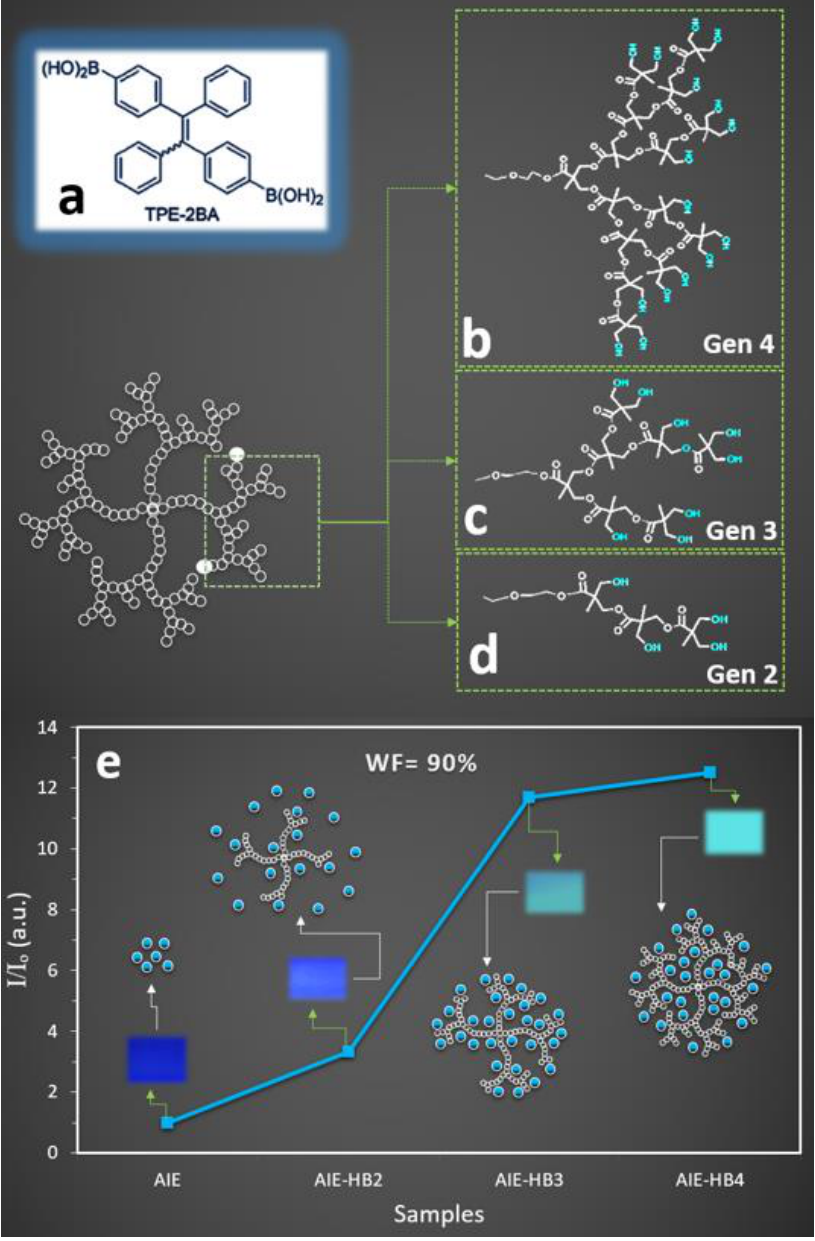
Figure 1. Chemical structures of ( a ) TPE-2BA (AIE) and schematic drawing of different types of the hyperbranched polymers (HBs) including the chemical structure of one branch only for, ( b ) generation 4, ( c ) generation 3, and ( d ) generation 2. ( e ) Change in relative fluorescence intensity of TPE-2BA-hyperbranched polymer (AIE-HB nanoprobe) at water fraction = 90% with AIE (blue circles) and HB (white circles) representing AIEgen and HB, respectively. The concentrations of TPE-2BA and all different generations of HBs were 50 μM and 1 mM, respectively, and the excitation wavelength was 310 nm. Insets: camera images of AIE and nanoprobe solutions at WF = 90% captured under a UV light with the excitation wavelength of 365 nm.